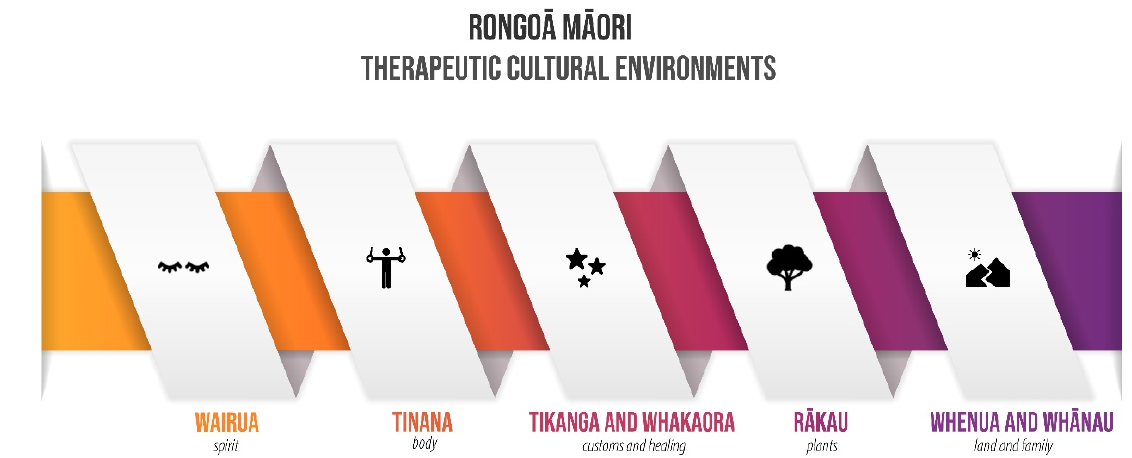
Figure 4. Elements that are part of therapeutic cultural environments based on Rongoā healers.